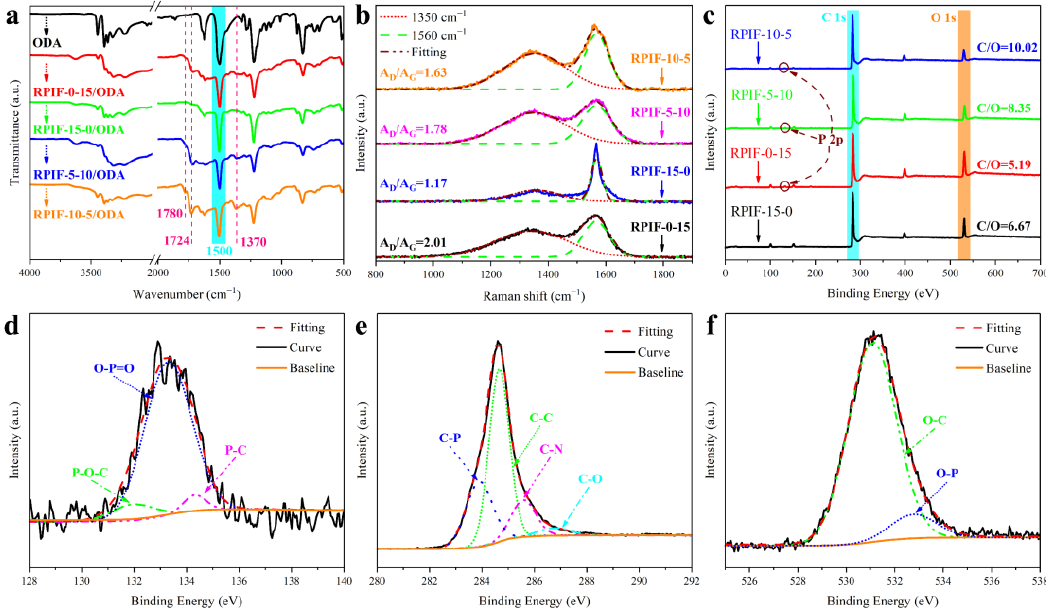
Figure 14. FT-IR spectra ( a ), Raman spectra ( b ), and XPS survey spectra ( c ) of the residue of RPIF with a total dosage of EG and PPCP at 15 wt. % after CCT; high-resolution P 2p ( d ), C 1s ( e ), and O 1s ( f ) XPS spectra of RPIF-10-5 residue after CCT.